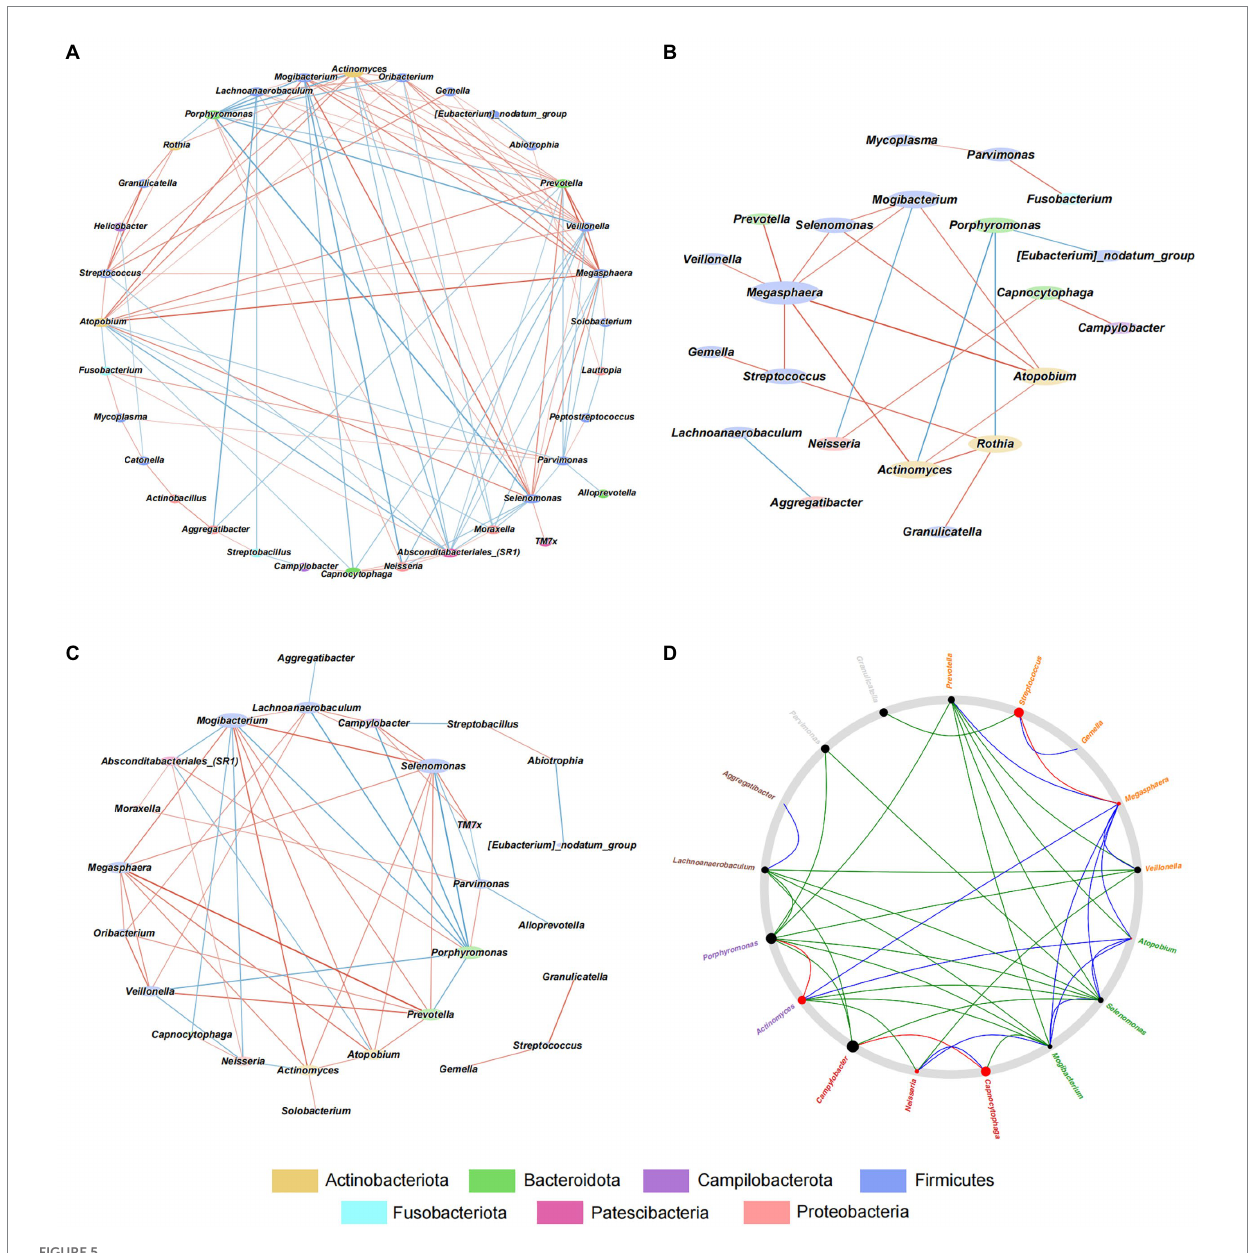
FIGURE 5 Interactive Network in HP − , HP+, and overall PCG at the genus level. (A) Interactive network analysis of HP − PCG. (B) Interactive network analysis of overall PCG. (C) Interactive Network analysis of HP+ PCG. (D) Netshift analysis of GJM between HP − and HP+ PCG.